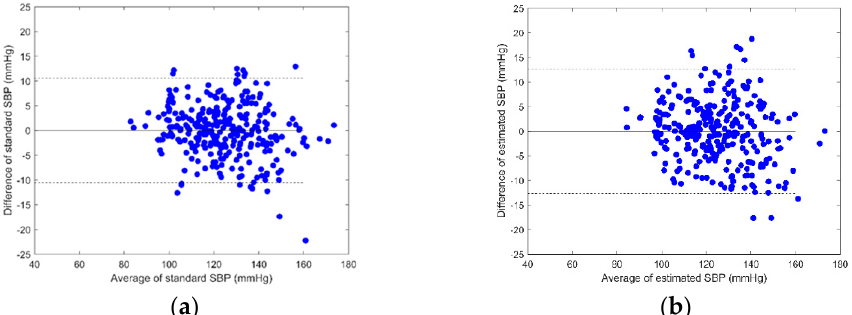
Figure 6. Bland–Altman plot of estimated SBPs by Equation (6) and ground-truth SBPs: ( a ) the reference method with ECG and PPG, ( b ) the proposed method with BCG and IPG.